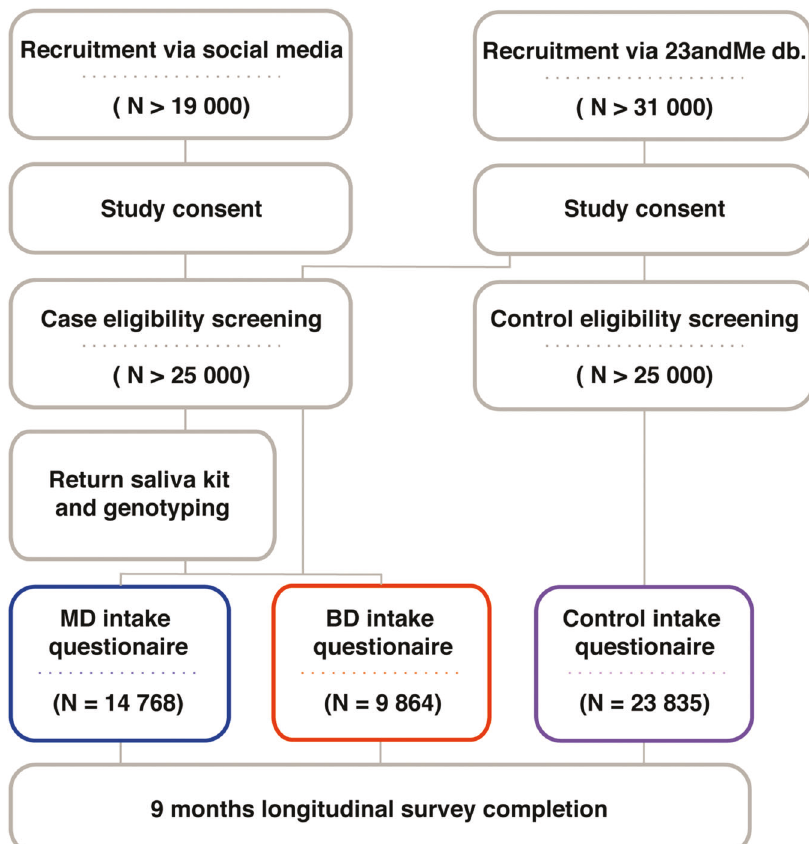
Fig. 1 Flowchart illustrating the enrollment. The procedural steps were: Informed consent, apply for enrollment and meet study inclusion and no exclusion criteria, return a saliva kit for genotyping (except for excisting costumers who purchased and returned a 23andMe kit prior to joining the study), and answer the baseline questionnaire. In the 9 months after enrolment, participants were asked to complete monthly surveys and cognitive